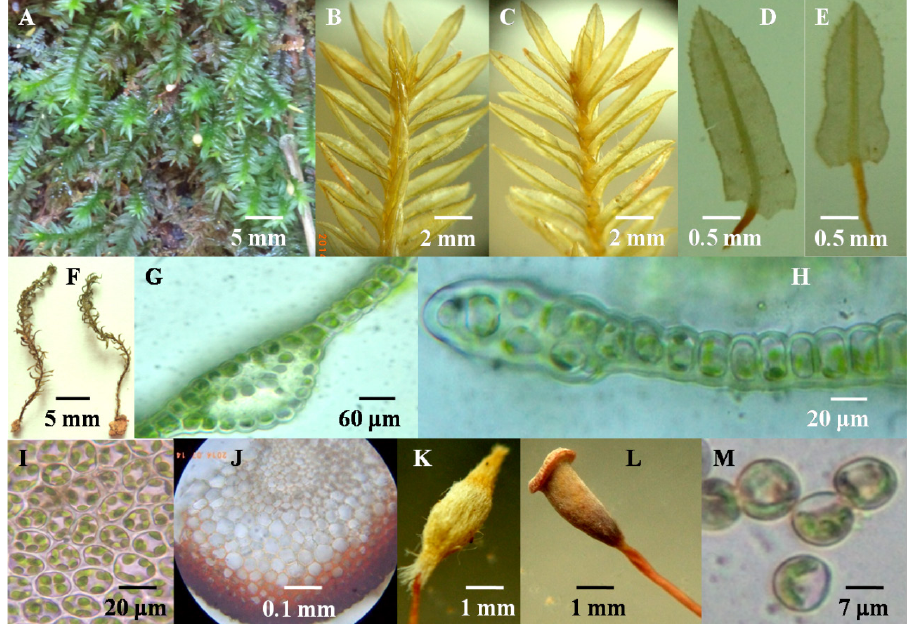
Figure 7: Pogonatum marginatum Mitt. (A) female gametophytes with spporophytes, (B) dorsal surface of fresh habit (C) ventral surface of fresh habit (D) ventral leaf, (E) dorsal leaf (F) dry habit (G) transverse section of leaf at the nerve (H) transverse section at the leaf margin (I) leaf lamina cells, (J) transverse section of stem (K) calyptra covering the capsule, (L) dry capsule (M)